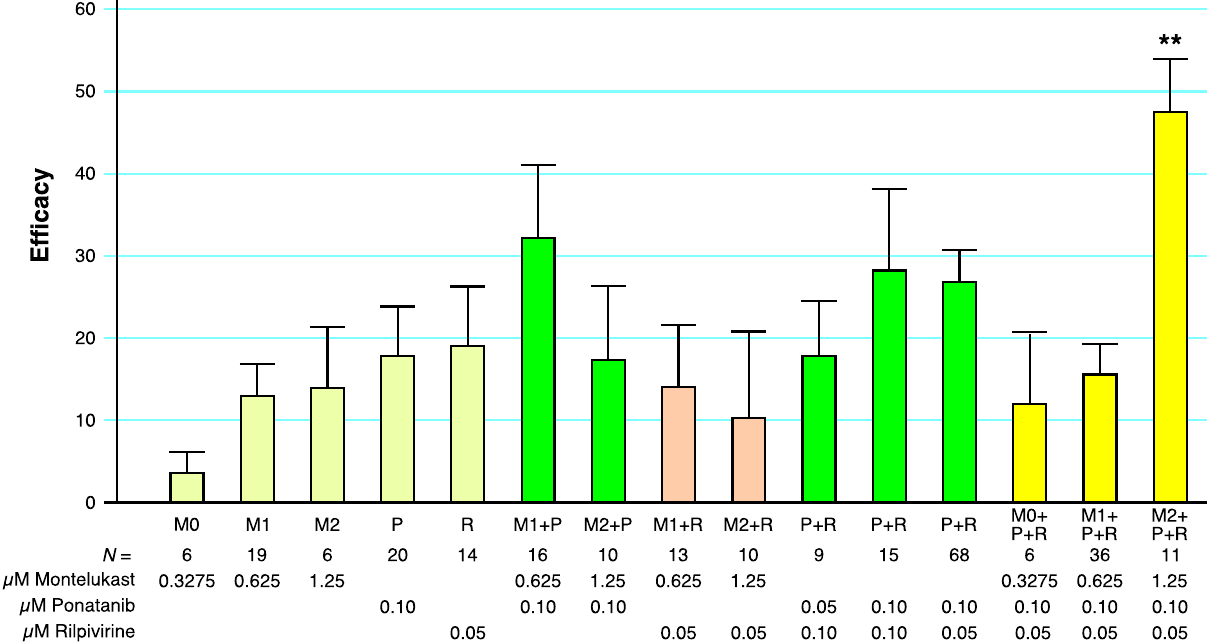
Figure 5. Comparative efficacies of drug combinations using Montelukast, Ponatinib, Rilpivirine. Efficacies were determined using compounds alone or in various combinations in Nsp1-transfected H1299 cells at the indicated concentrations. Measurements were conducted with N replicates and error bars represent ± SEM. One combination (M2 + P + R) displayed greater Efficacy than other combinations shown in this graph. A one-way ANOVA analyses indicates that there is significant difference between the means of at least two drug combinations ( F 14, 243 = 1.985, p = 0.02). Eliminating M2 + P + R from the analyses rendered the one-way ANOVA not significant ( F 13, 233 = 1.274, p =